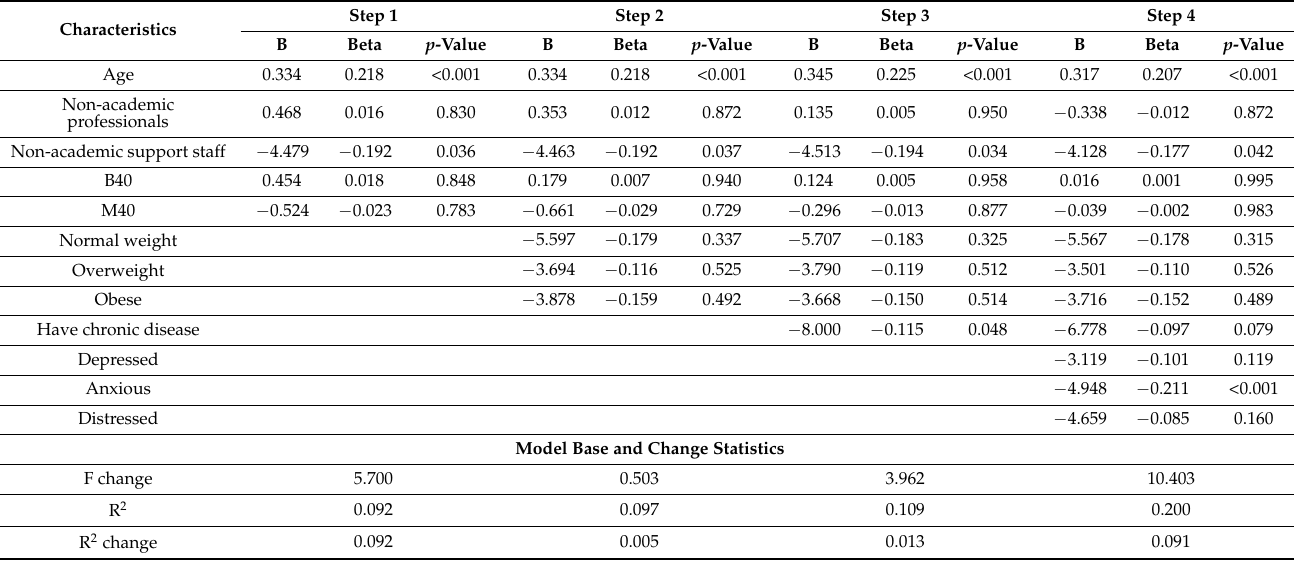
Table 7. Factors associated with environmental HRQoL according to the hierarchical multiple linear regression analysis.